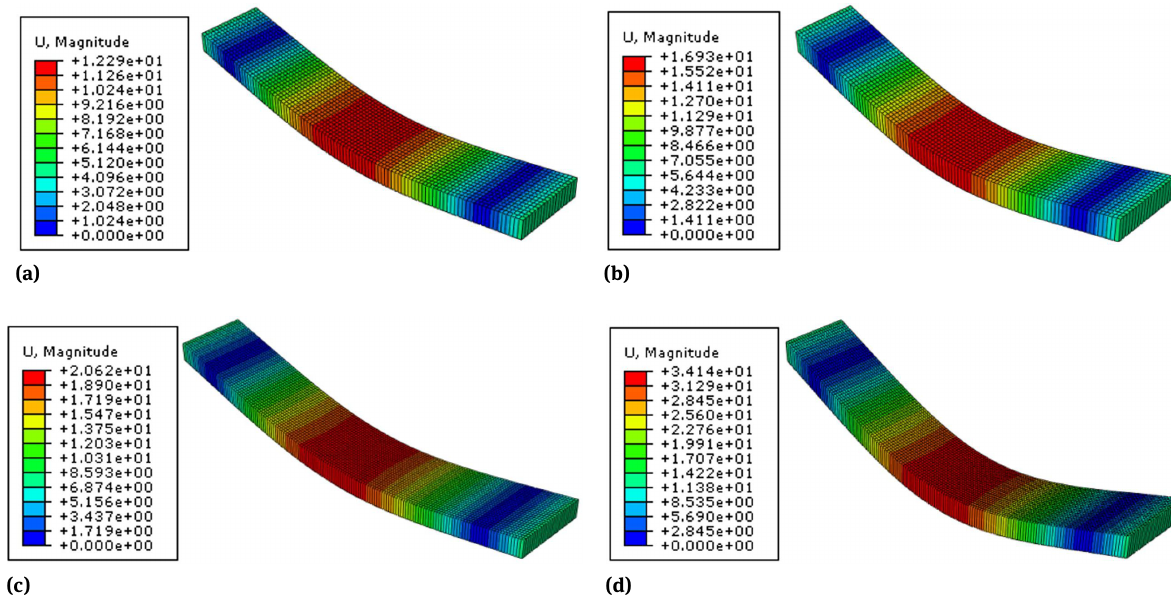
Figure 16: Estimation of deformation through linear perturbation method (linear elastic): (a) laminate type 1, (b) laminate type 2, (c) lami- nate type 3, (d) laminate type 4